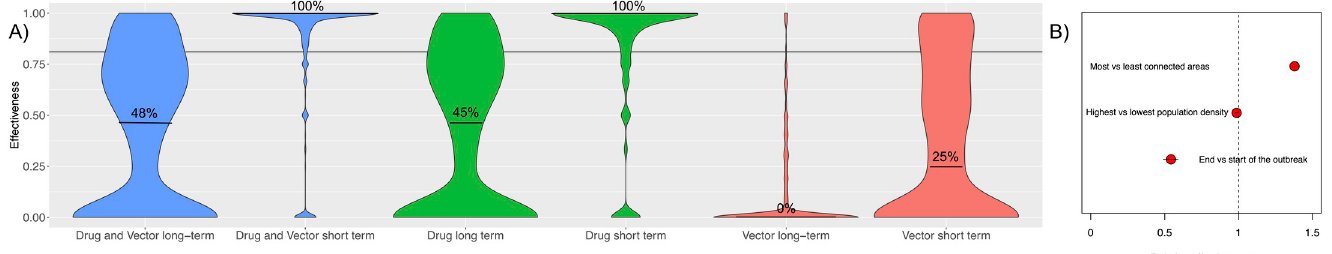
Fig 6. Within patch effectiveness of case-area targeted interventions. A) Effectiveness compares proportion of symptomatic cases in areas treated with prophylactic drugs and adult vector control over the short (30 day) and long (365 day) time periods. Both drugs and vector control are predicted to have 81% effective coverage (solid horizontal line) deployed the day after index case detection within a 1km radius of the index case, maintaining efficacy for 30 days. B) Relative effectiveness between the highest and lowest value pixels with respect to three characteristics (as predicted by a multivariate model fit to the long-term drug effectiveness